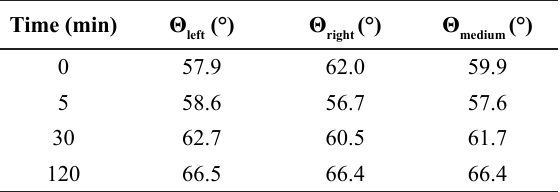
Contact angle measurements for ITO-PAMAM- (PSS/PAMAM)2-AuNPs electrodes modified with